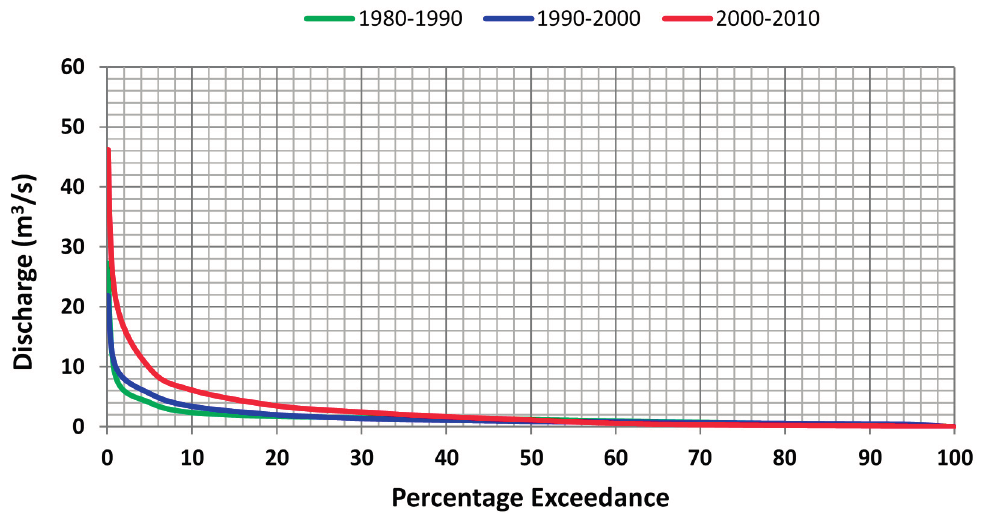
Figure 11. Flow duration curves in the Mukuvisi catchment for the periods 1980–1990, 1990–2000 and